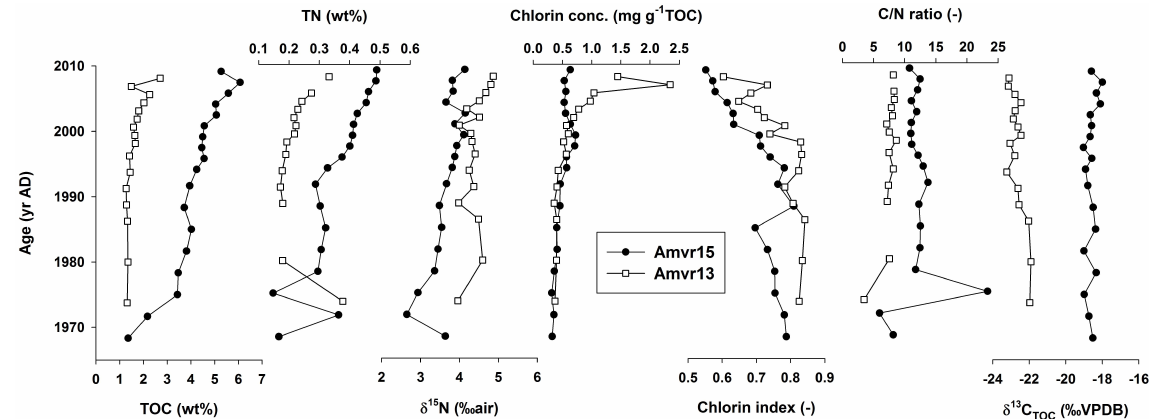
Fig. 5. Bulk parameters of cores Amvr13 and Amvr15 plotted vs. age (yrAD), including the concentrations of total organic carbon (TOC), total nitrogen (TN), nitrogen isotopic composition ( δ 15 N, ‰ air), chlorin concentrations (mgg − 1 TOC), chlorin index (CI), the C/N ratio and the TOC isotopic composition ( δ 13 C TOC , ‰ VPDB).